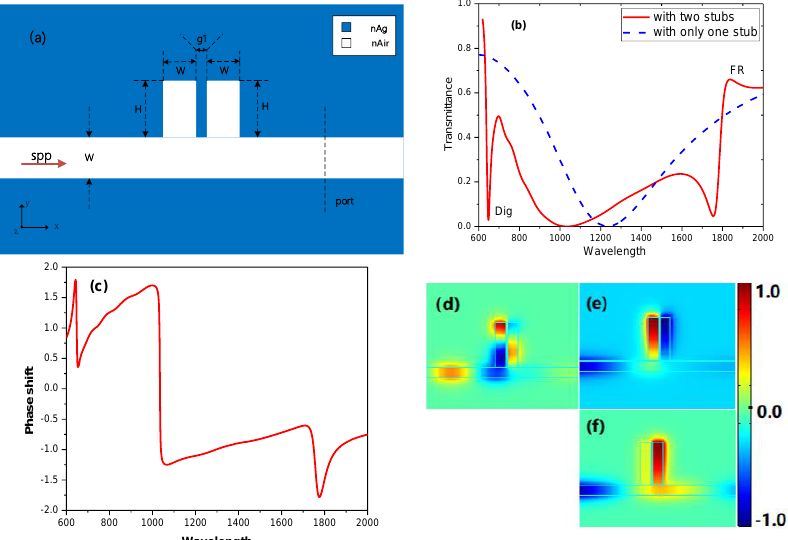
Figure 1. ( a ) The schematic diagram of the basic model composed of two stubs and a metal-insulator-metal (MIM) waveguide structure. ( b ) The red solid line: the transmittance spectrum of the basic model (two coupling stubs) with H = 200 nm and g1 = 10 nm; the blue dash line: the transmittance spectrum of the MIM waveguide with only one stub, herein, H = 200 nm and g1 = 10 nm. ( c ) The phase shift spectrum of the basic model. ( d ) The 𝐻 𝑧 field intensity distribution at Dip, i.e., λ = 648 nm. ( e ) The 𝐻 𝑧 field intensity distribution at the Fano resonance dip, i.e., λ = 1754 nm. ( f ) The 𝐻 𝑧 field intensity distribution at the FR, i.e., λ = 1837 nm.